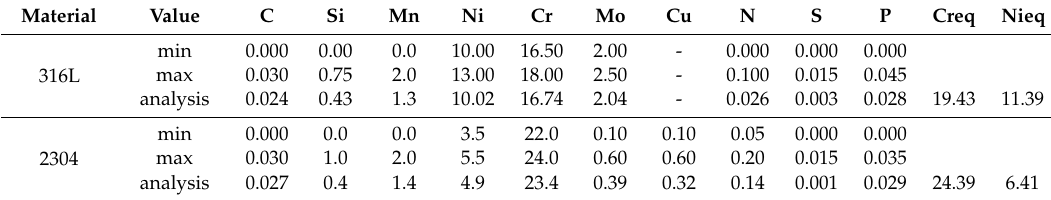
Table 1. Chemical composition of base materials,